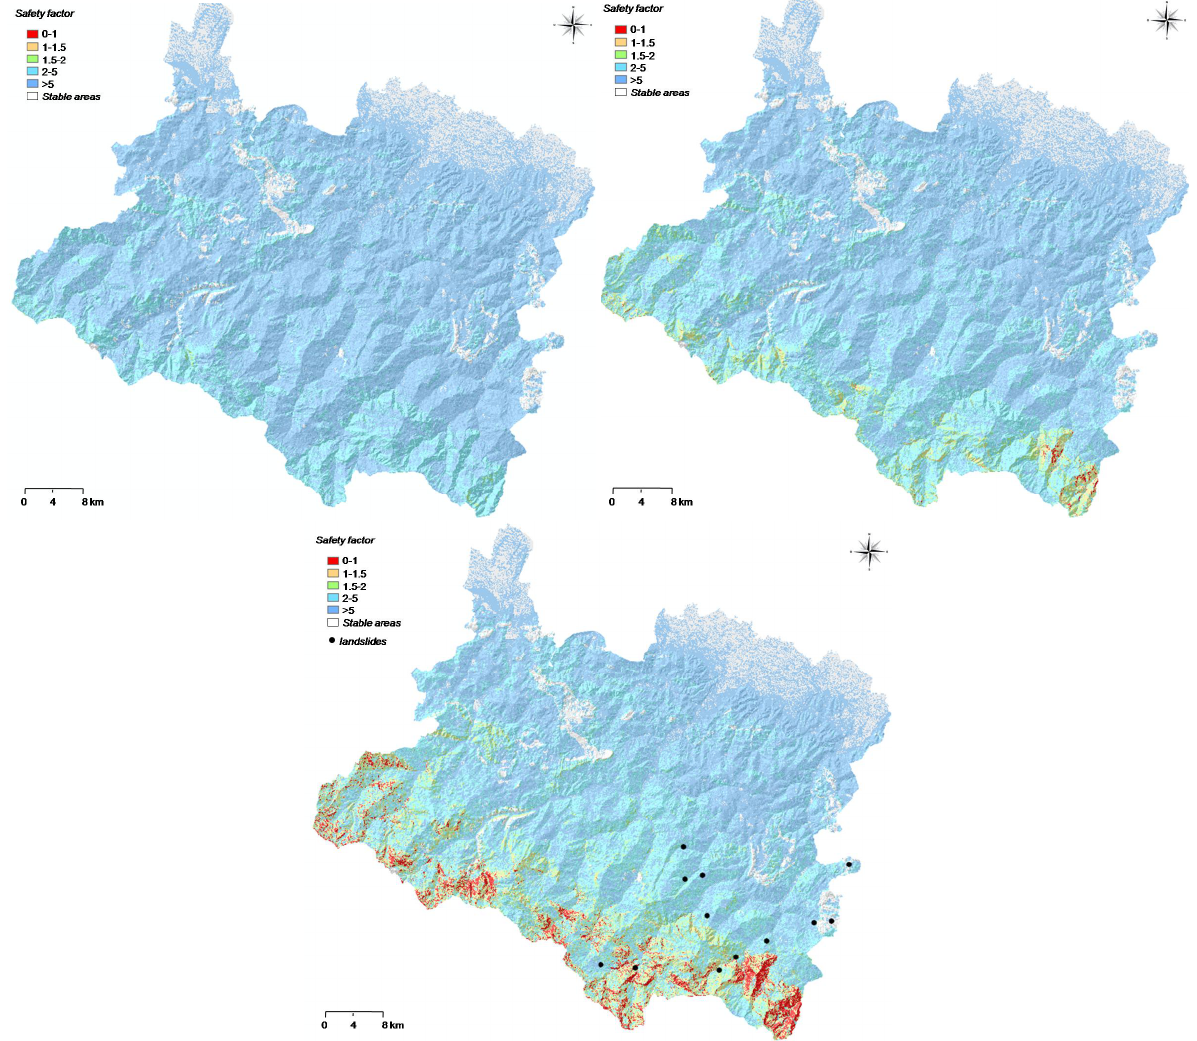
Fig. 14. SLIP analysis on the study area: time-varying maps of F s corresponding to the events occurred in December 2005 (3% of unstable Figure 14c areas). (a) F s map on the 1 December 2005; (b) F s map on the 2 December 2005; (c) F s map on the 3 December 2005. Each elementary cell is 20m ×